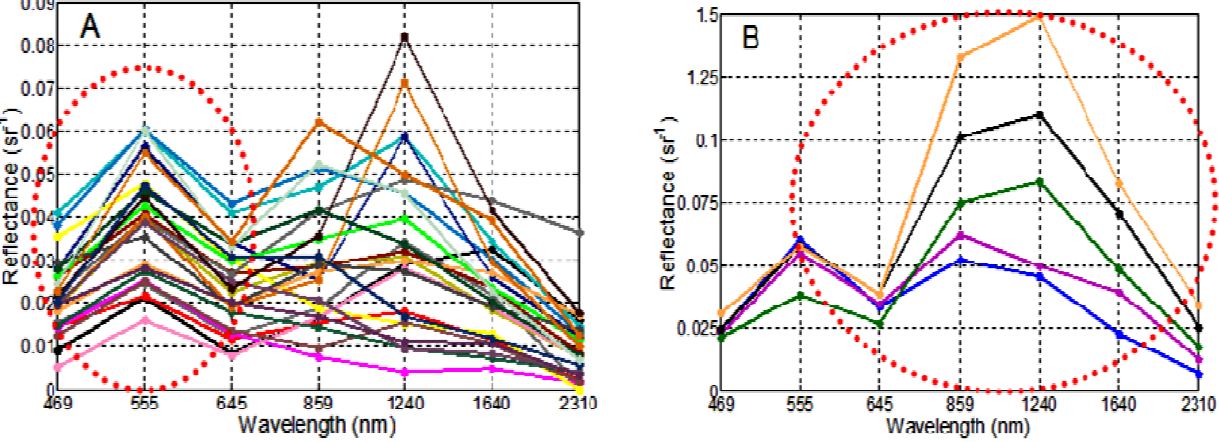
Figure 5. Spectral signature behaviour for three chlorophyll-a concentration classes: ( A ) low (<10 mg·m − 3 ) and moderate (10–50 mg·m − 3 ) concentrations combined; and ( B ) high concentrations (>50 mg·m − 3 ). Different colors represent the signature of individual samples.